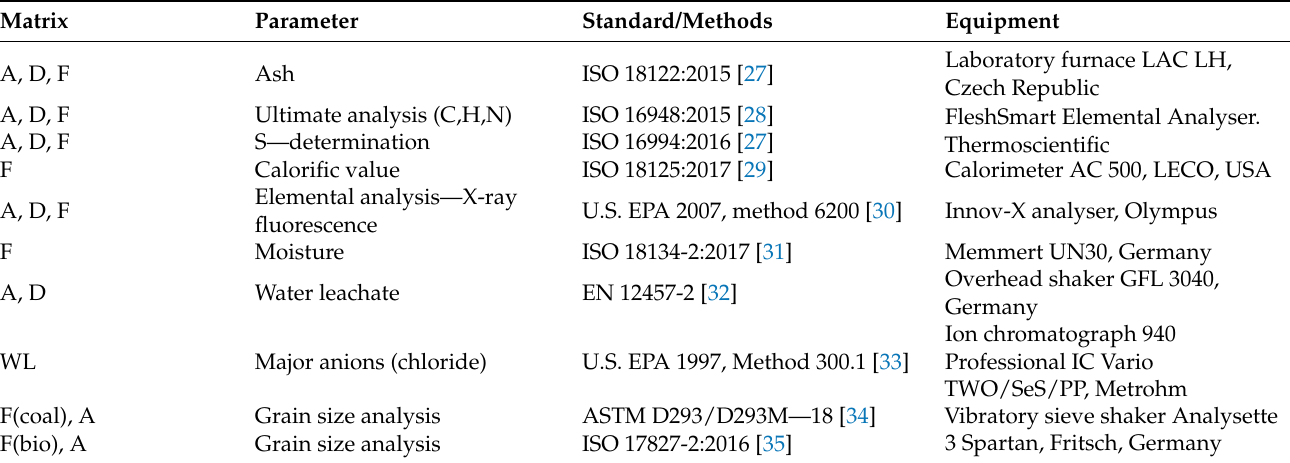
Table 3. Overview of standardised methods